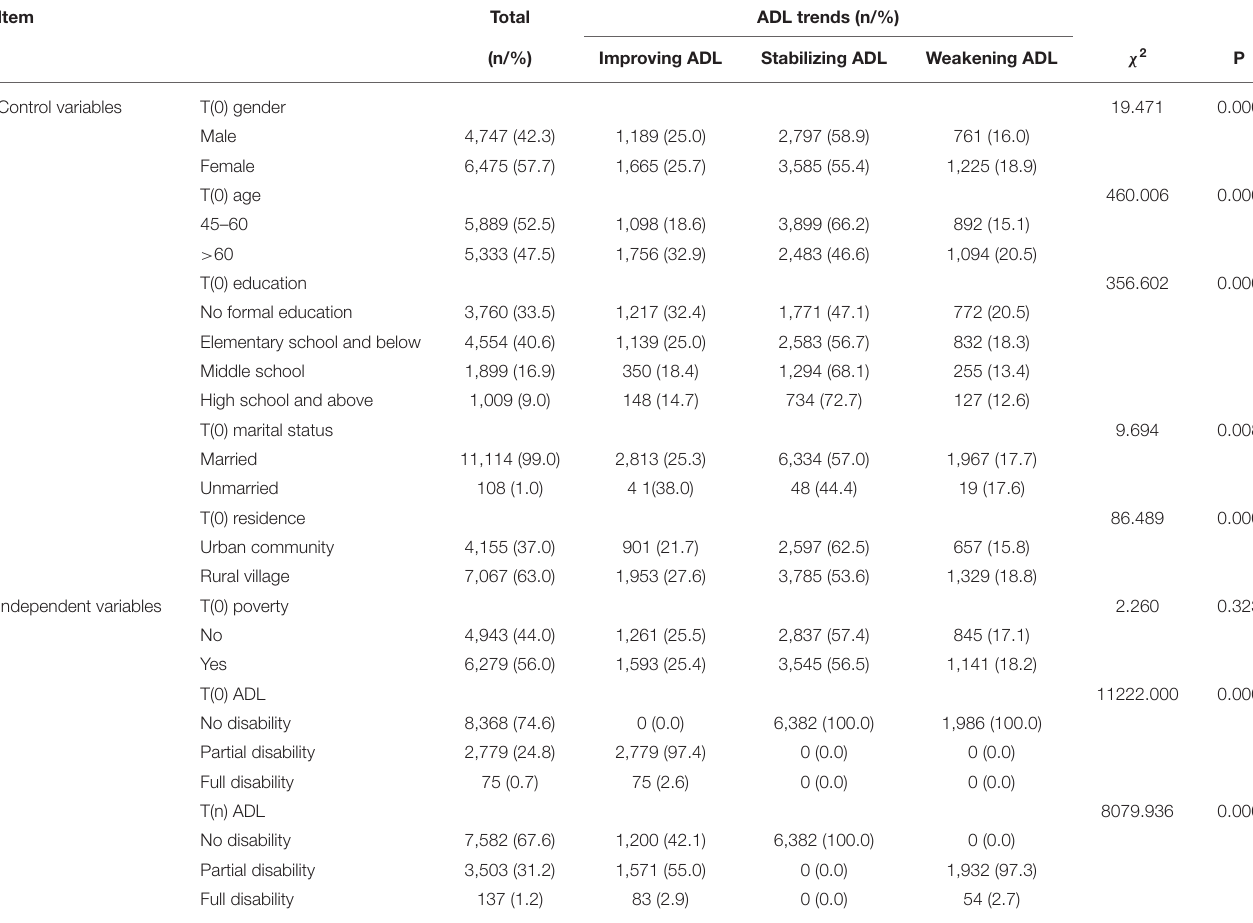
TABLE 3 | Sample characteristics in T(0) and the ADL trends comparison within subgroups of T(0) economic conditions or T(0) control variables.